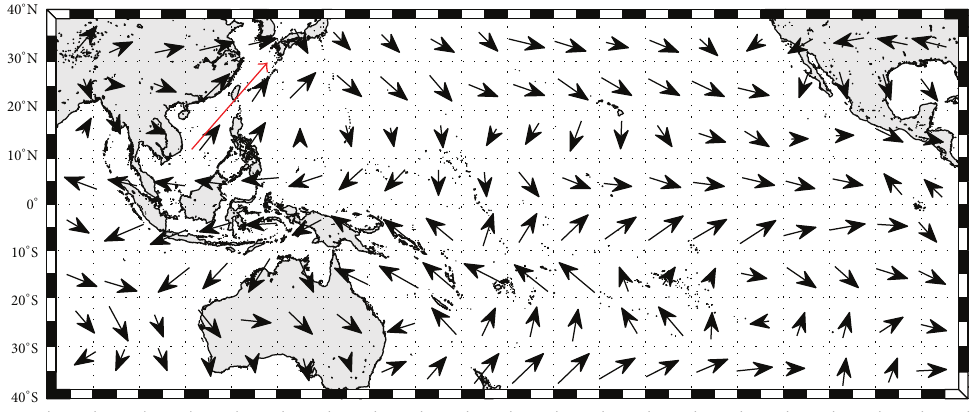
Figure 4: Anomalous patterns of wind vector over the Western Pacific during canonical El Nino episodes. The red arrow indicates the wind direction near Taiwan (sketched based on Feng and Li [19]).